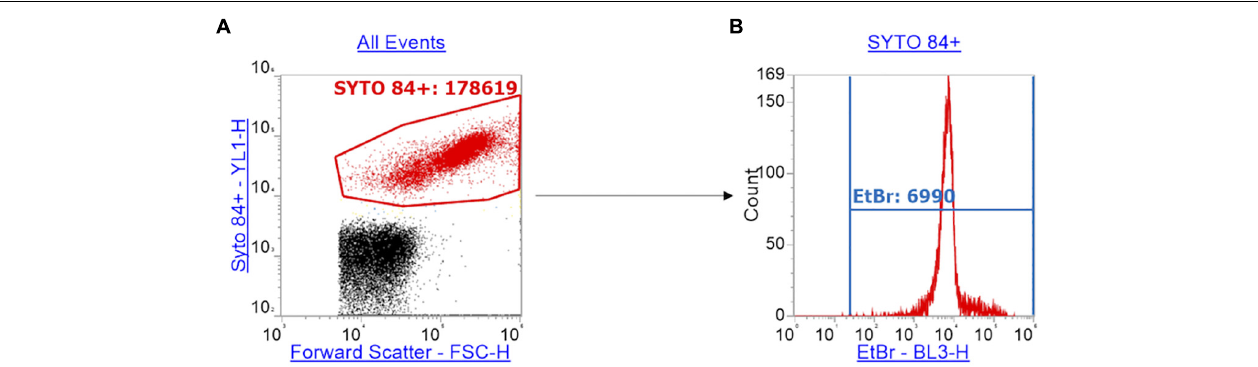
FIGURE 1 | Gating strategy for the measurement of ethidium bromide RFU. Panel (A) shows how cells (red) were separated from background debris (black) by gating SYTO TM 84 + cells (red) using a plot of the orange fluorescence emission channel YL1-H (SYTO TM 84 fluorescence) against forward scatter (FSC-H). (B) Using the red gate of SYTO TM 84 + population, a histogram of ethidium bromide fluorescence per cell was plotted using the emission channel BL3-H. The ethidium bromide gate (blue) gives the x-median of ethidium bromide fluorescence to measure relative accumulation.